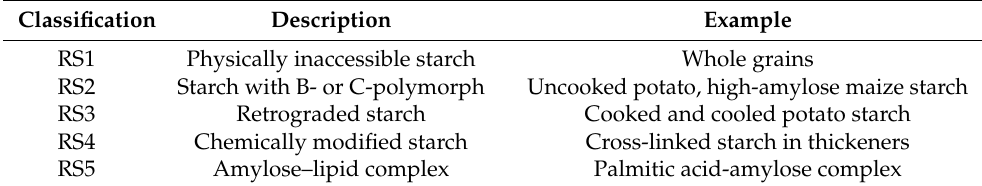
Table 1. Classification of RS and example of foods rich in